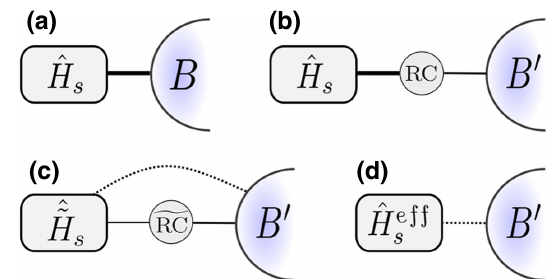
FIG. 2. A diagrammatic representation of the RCPT Hamilto- nian transformations and truncation. (a) The original model: an open system ( ˆ H s ) coupled to a bosonic bath ( B ). (b) The system is extended to include a reaction coordinate, which is extracted from the reservoir, leaving a residual bath B (cid:3) missing one mode. (c) The model after the application of the polaron transforma- tion: the rotated system Hamiltonian connects to both the RC and the residual bath. (d) The model after the truncation of the RC, resulting in a so-called effective Hamiltonian with the sys- tem coupled only to the residual bath. This model is reminiscent of the original system in